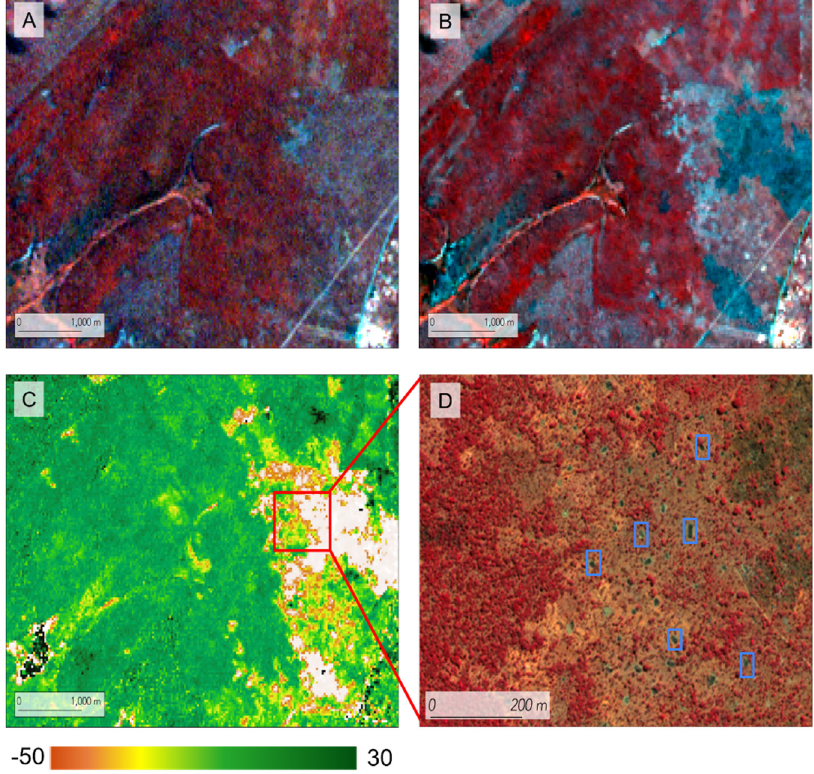
Figure 3. ( A ) Landsat 8 false-color composition (1,2,5) for the year 2018 in the Mkushi forest reserve; ( B ) Landsat 8 false-color composition (1,2,5) for the year 2019; ( C ) normalized difference of NDVI images from consecutive years; ( D ) detailed false-color composition view (1,2,4) of a WorldView-2 image (2 m spatial resolution) displaying kiln scars. Some kiln scars are marked (blue rectangles) as a visual